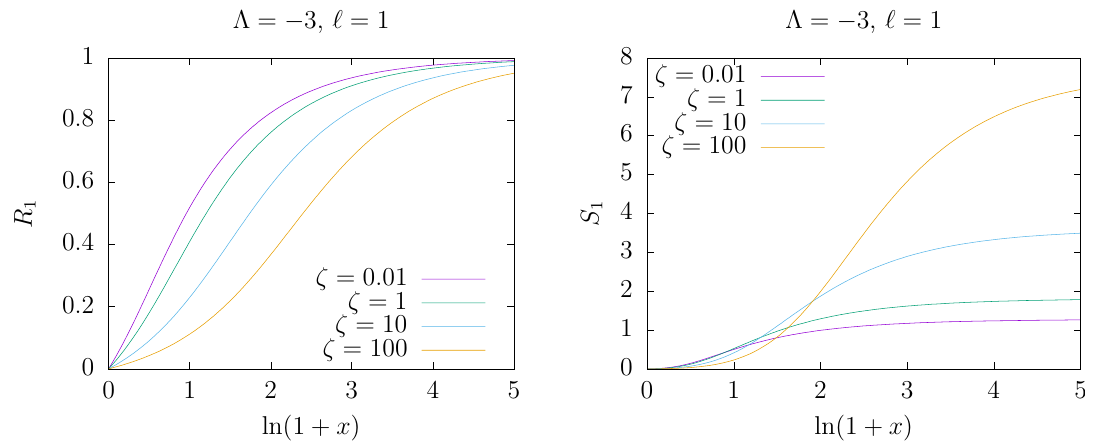
Figure 1 . Left: the pro(cid:12)le of the radial part of the electric dipole, R 1 ( x ), in function of ln (1 + x ) for di(cid:11)erent values of (cid:16) (with increasing values of (cid:16) from left to right). Right: the pro(cid:12)le of the radial part of the magnetic dipole, S 1 ( x ), in function of ln (1 + x ) for di(cid:11)erent values of (cid:16) (with increasing values of (cid:16) from bottom to